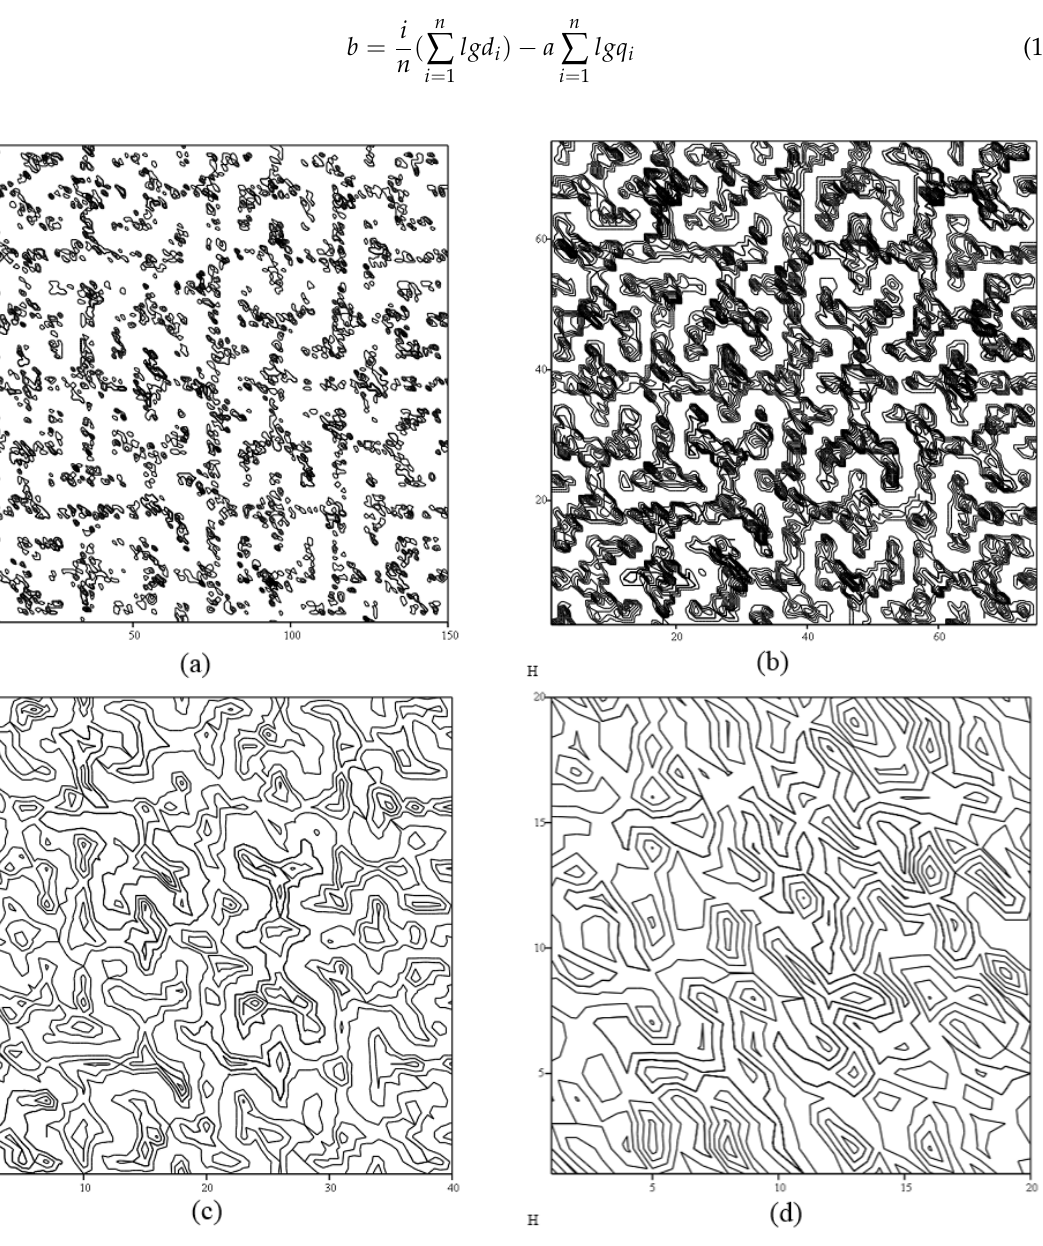
Figure 7. Results of aggregation of the model structure at q = 1 m 2 ( a ), 4 m 2 ( b ), 14 m 2 ( c ) 56 m 2 ( d